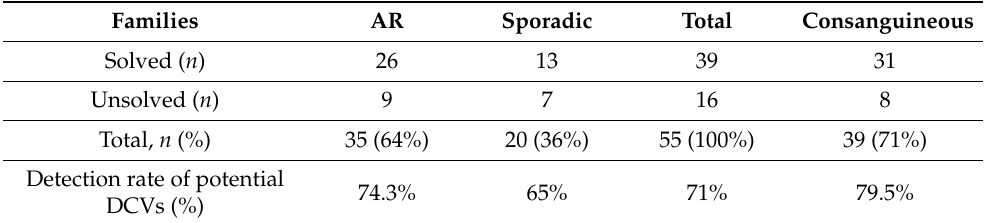
Table 1. Distribution and detection rates in patients with inherited retinal dystrophy.